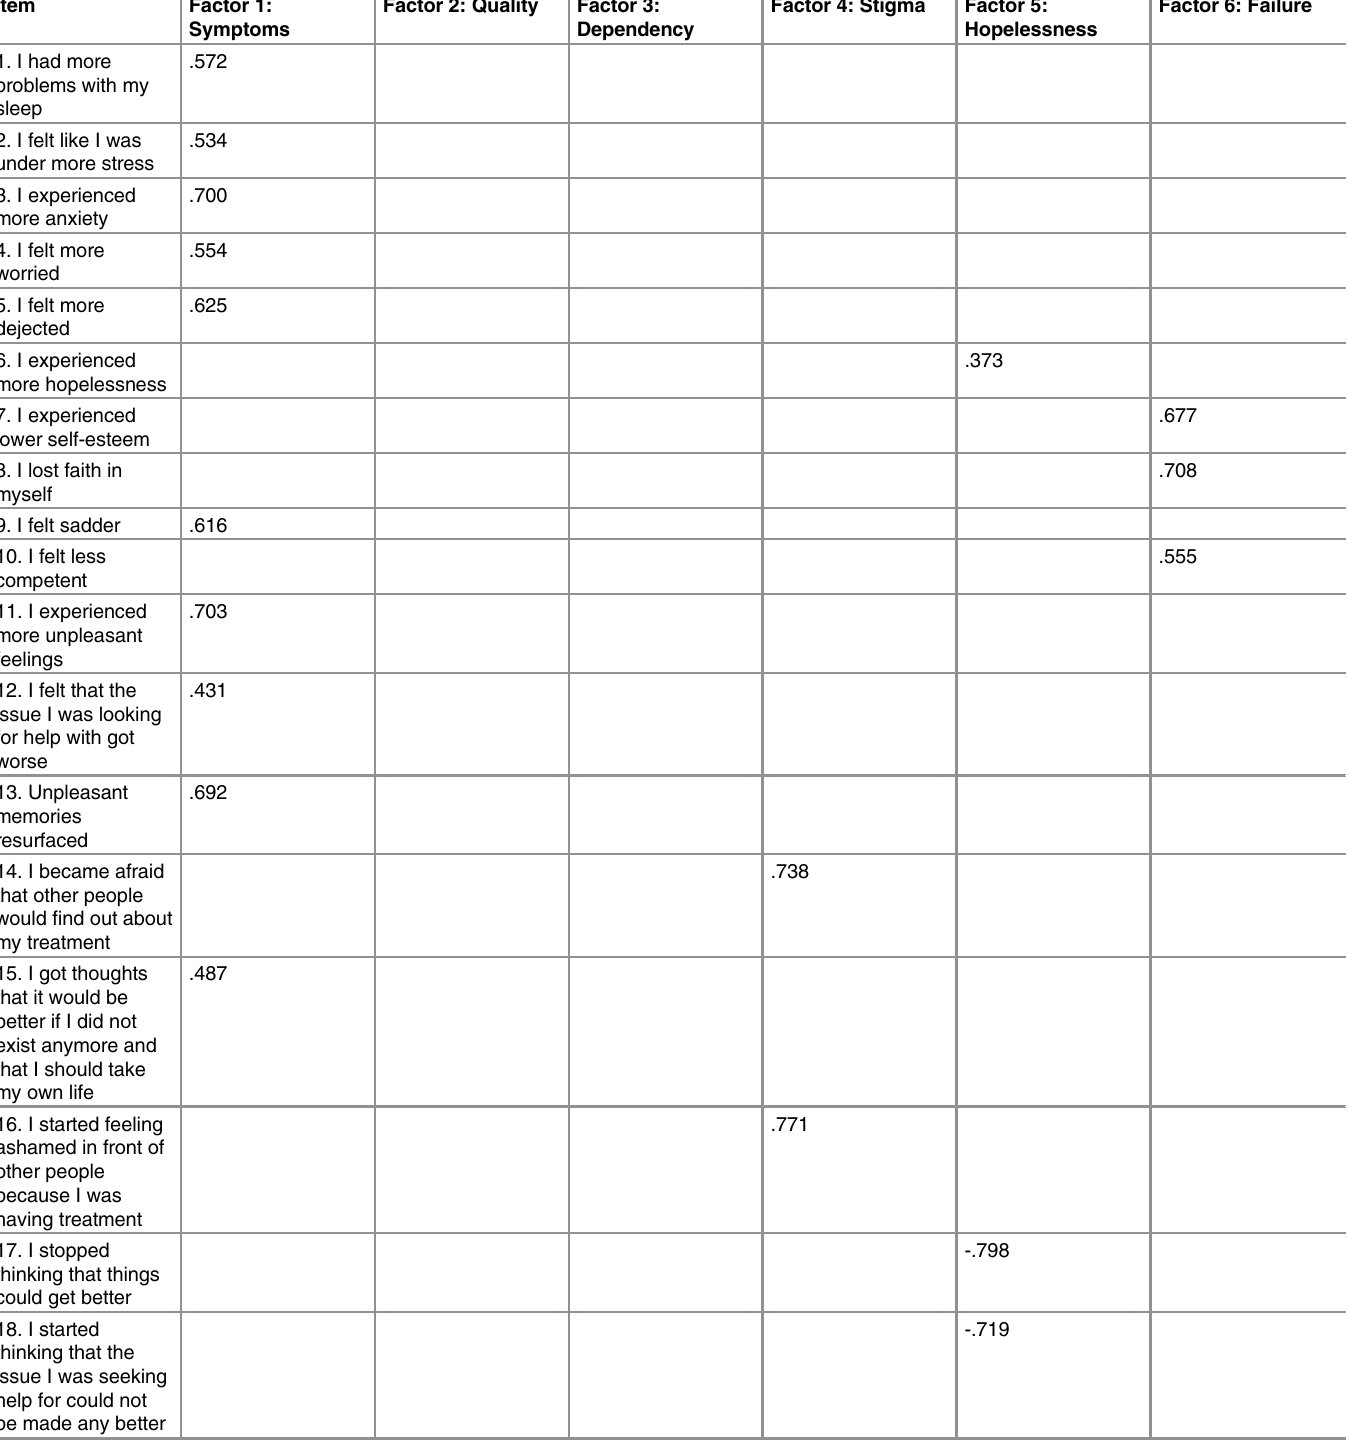
Table 2. Principal axis factoring for a six factor solution using oblique